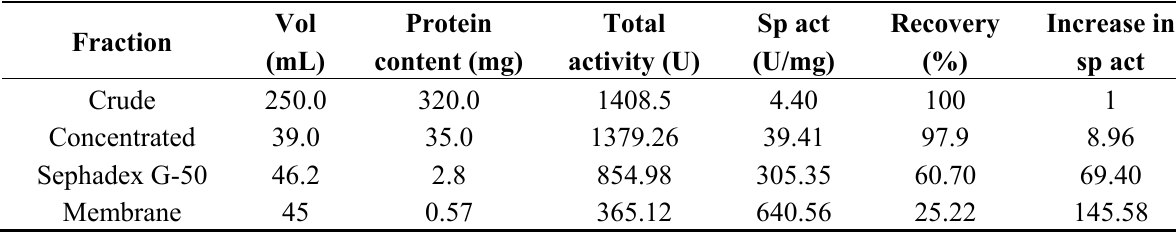
Table 1. Overall purification of the thermophilic DNase a